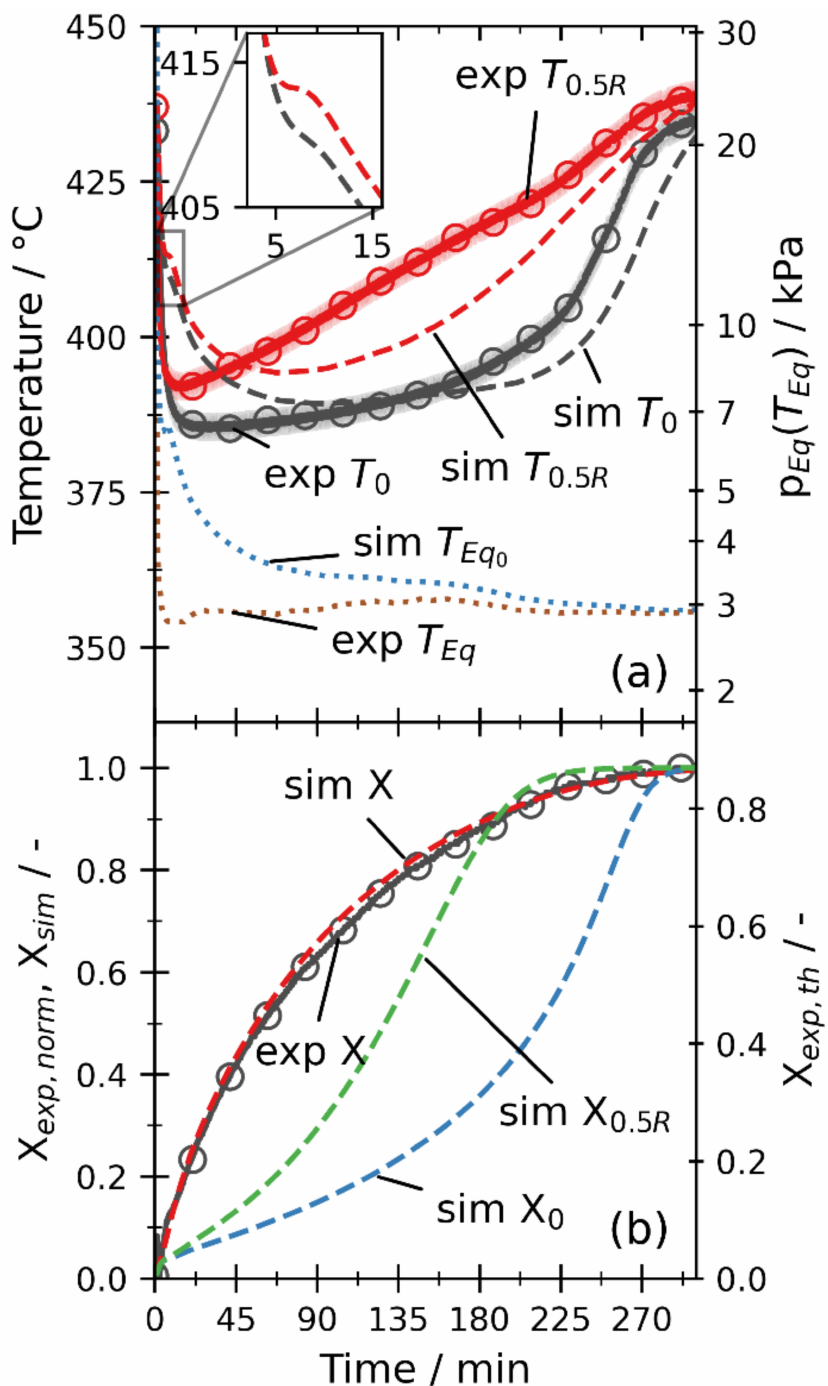
Figure 6. Comparison of the experimental and numerical results of temperatures ( a ) and conversions ( b ) for E7. The heaters are set to 450 ◦ C, and the dehydration is induced by a pressure reduction to 3 kPa. A particle diameter of 5 µ m is used for the simulation. The MAEs amount to 6 K, 7.8 K, and 0.01 for T 0 , T 0.5R , and the conversion,